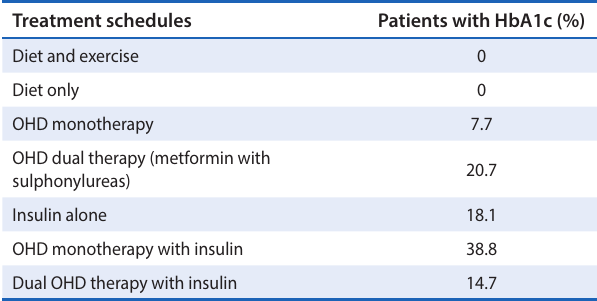
Note: OHD = oral hypoglycaemic drug.